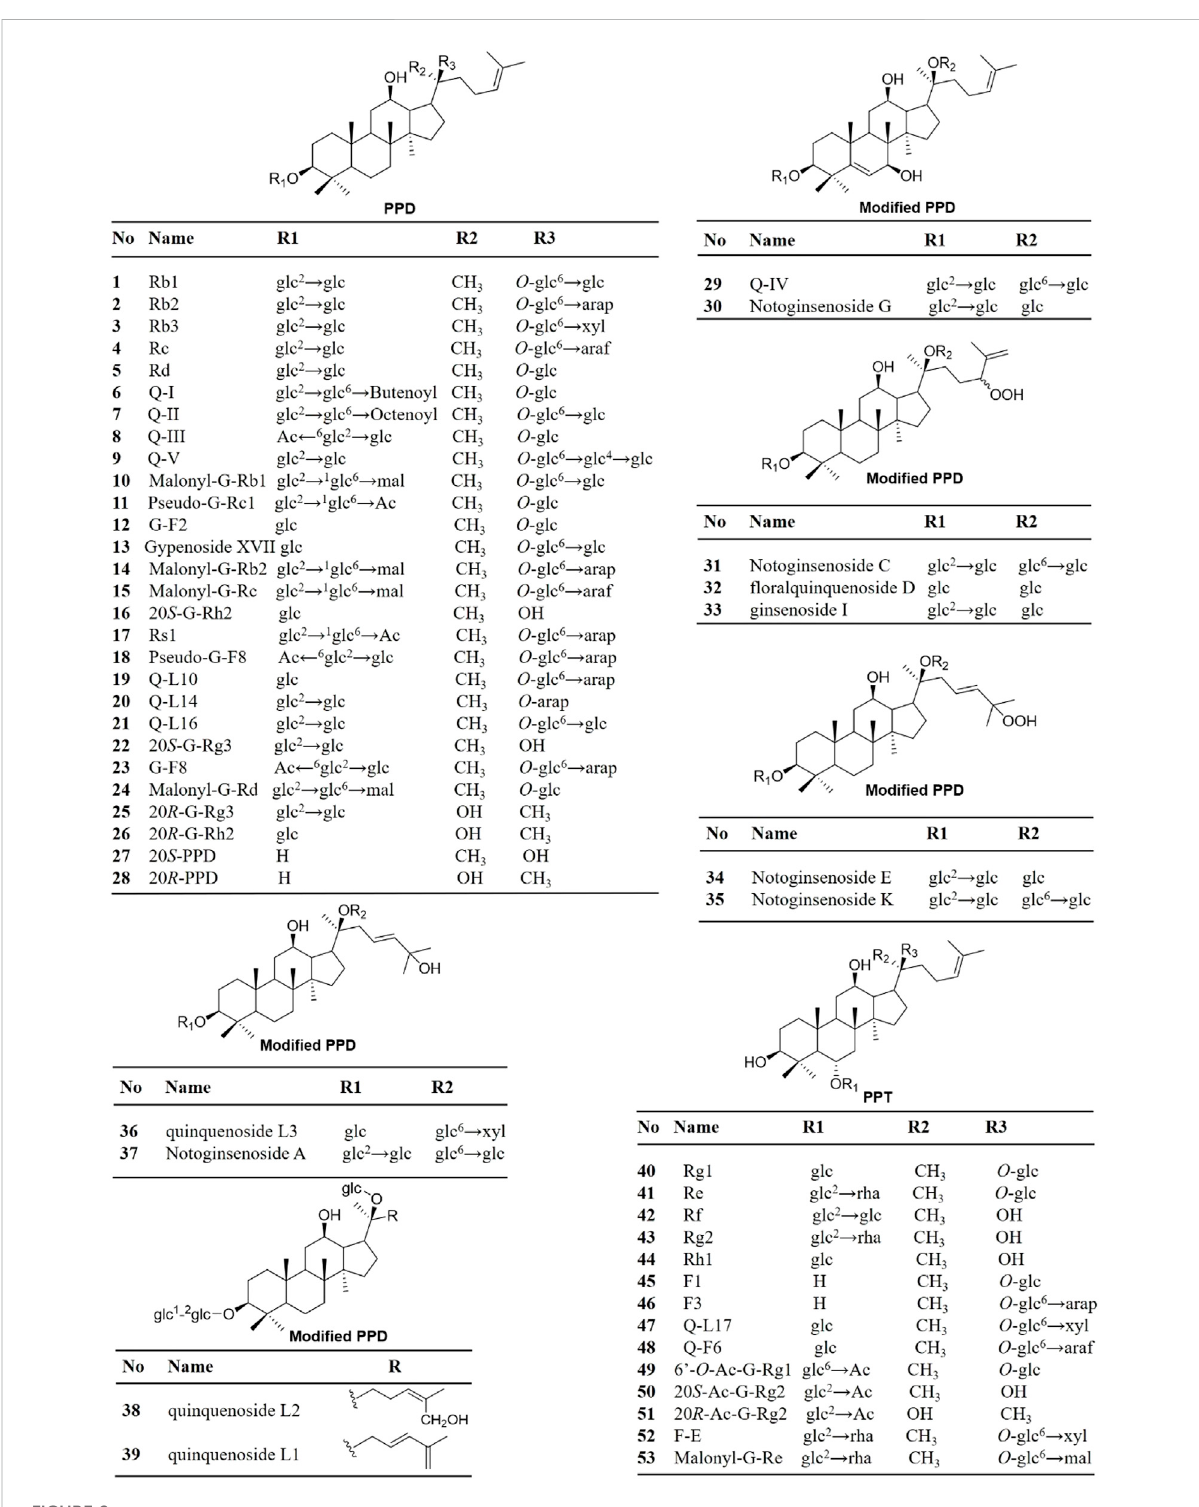
FIGURE 2 Ginsenosides characterized from P. quinquefolius . PPD, Protopanaxadiol; PPT, protopanaxatriol; G, ginsenoside; Q,